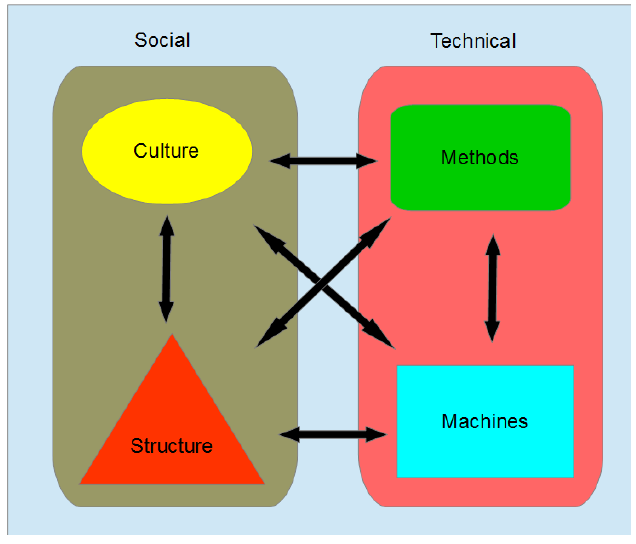
Figure 4 . Socio-technical System